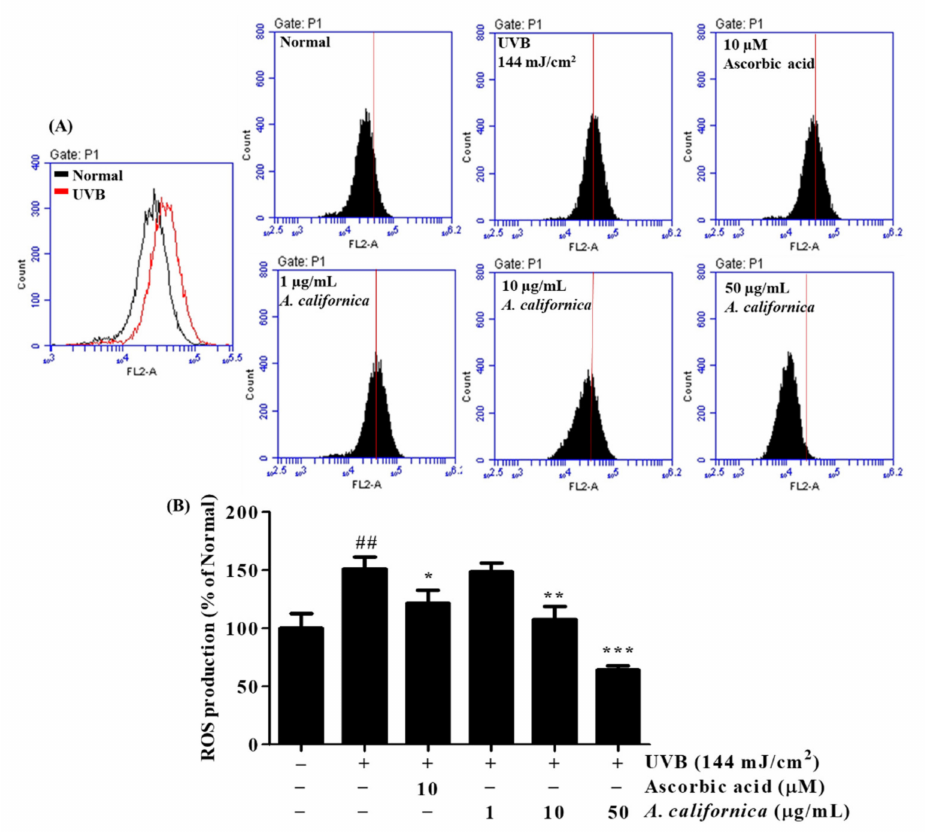
Figure 4. Effect of A. californica extract on levels of intracellular reactive oxygen species (ROS) in UVB- irradiated HDF cells. After 24 h of treatment, intracellular ROS level was measured. The number of cells is plotted versus the dichlorofluorescein fluorescence detected by the FL-2 channel ( A ). Results are presented as histograms ( B ). Data are presented as the mean ± SD. * indicate significant differences from the non-irradiated control and UVB-treated groups, respectively. ## p < 0.01 vs. the non-treated group. *, ** and *** p < 0.05, 0.01 and 0.001 vs. the UVB-treated control,